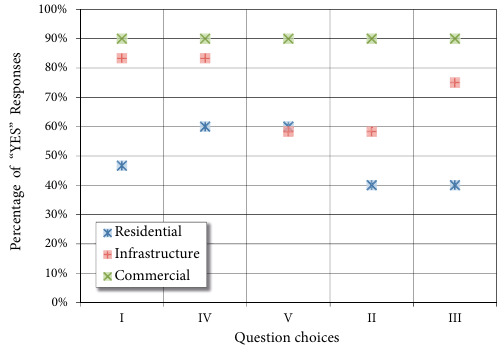
Fig. 13. Efforts spent in promotion activities according to key interest fields